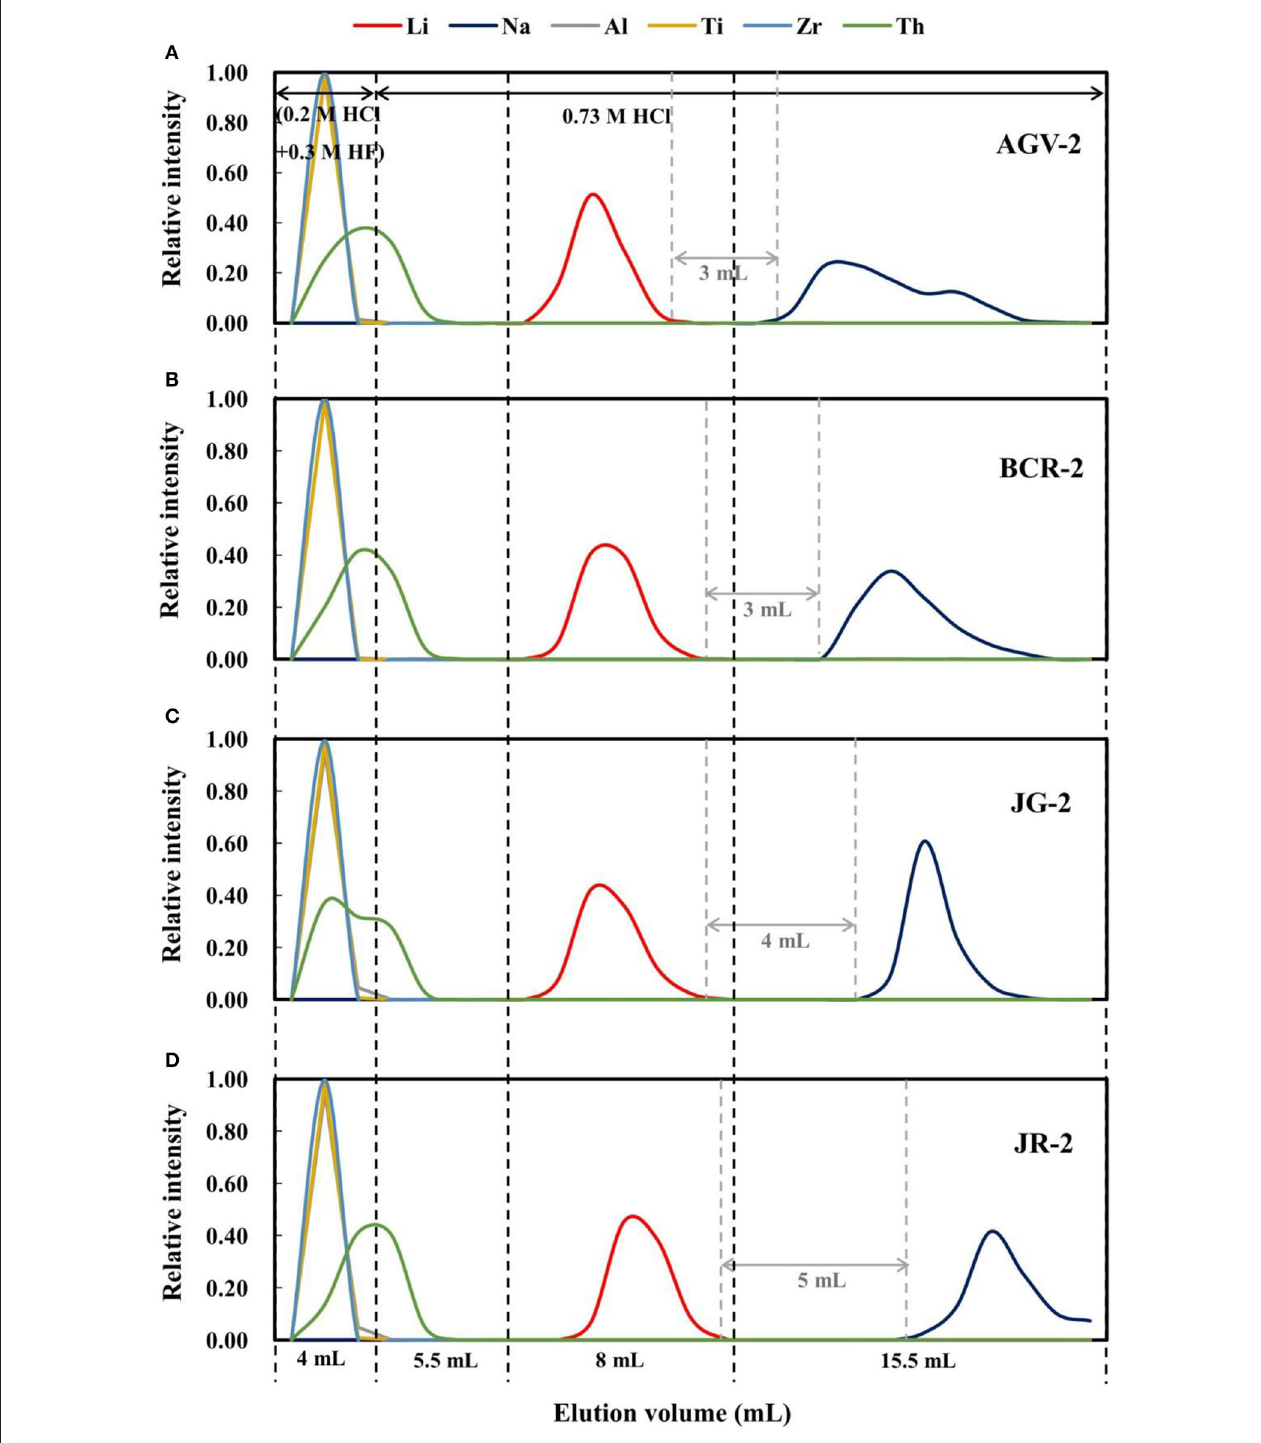
FIGURE 1 | Elution curves for four international rock standard materials on AGMP-50 resin: (A) AGV-2; (B) BCR-2; (C) JG-2; (D) JR-2. The relative intensity for all elements represents the percentage content in each elution fraction relative to the total content loaded onto the column.